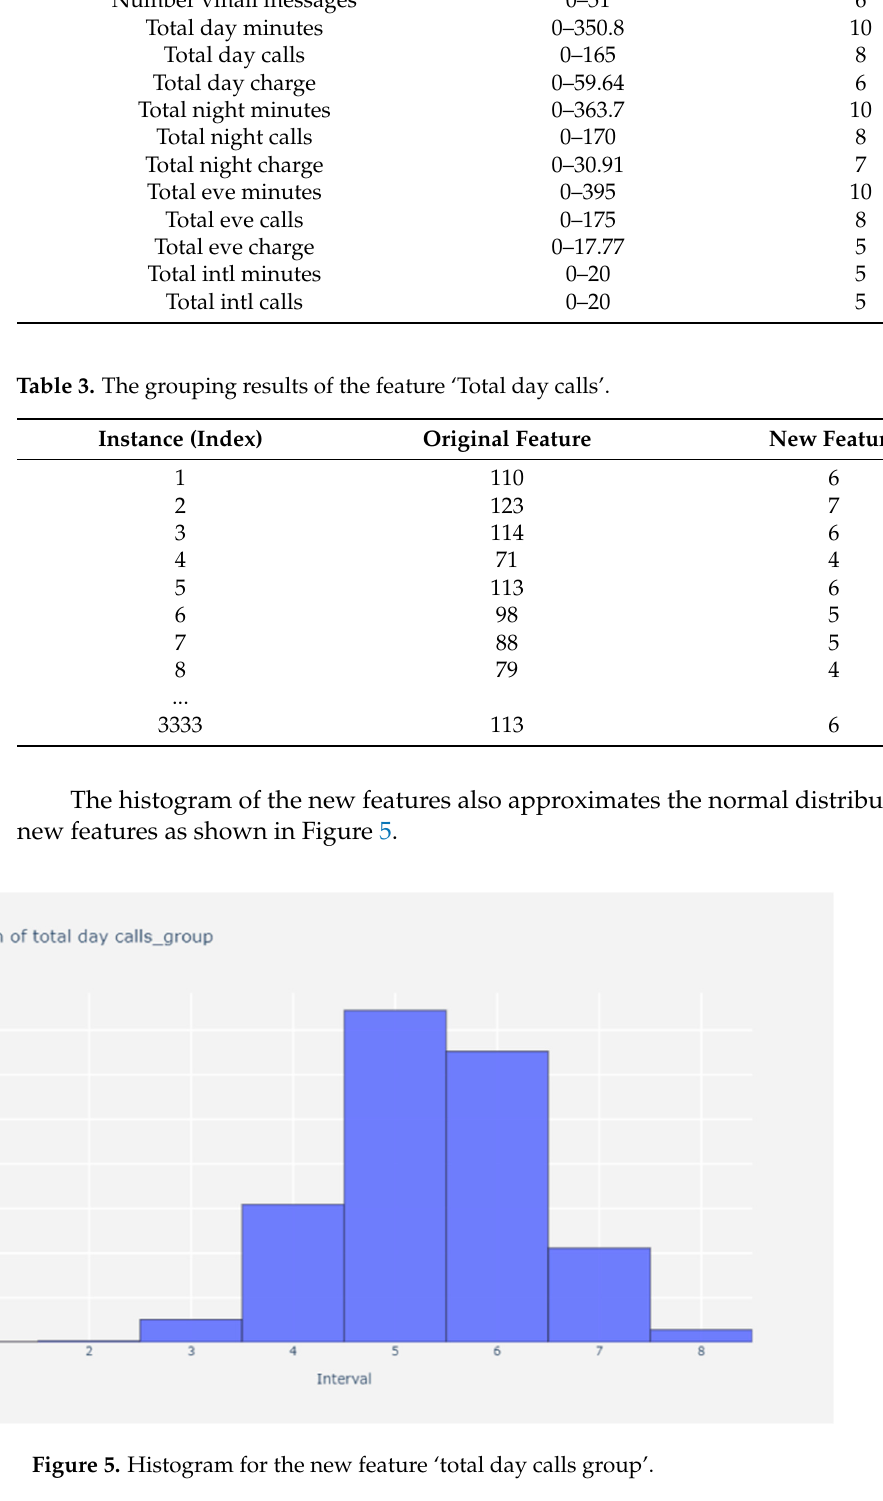
Figure 6. The new dataset after feature construction.